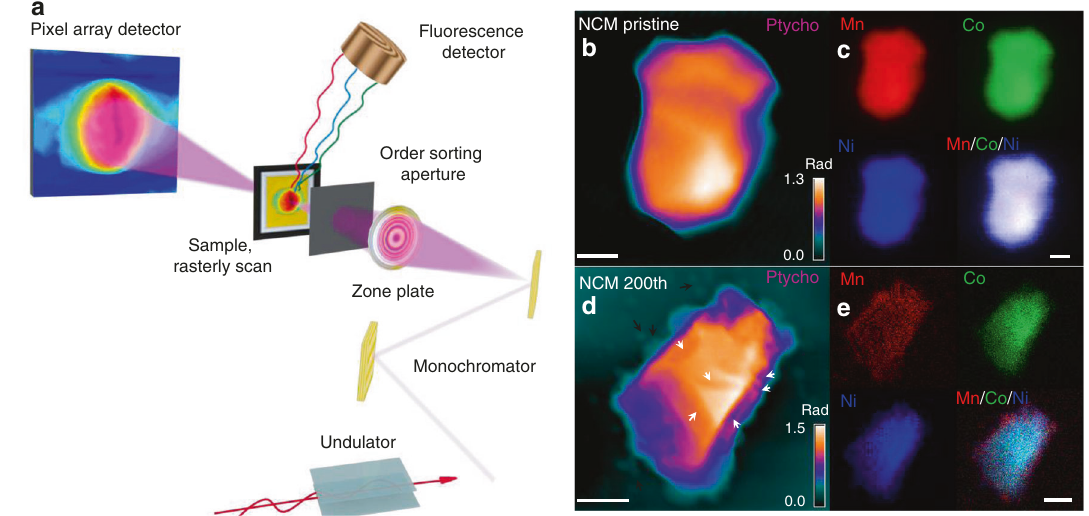
Fig. 5 Simultaneous X-ray fl uorescence and ptychography. a Experimental schematics. b – e X-ray fl uorescence and ptychographic images of pristine and 200th cycled NCM particles to show element distribution and morphology. Scale bars: b 2 μ m, c 1 μ m, d 2 μ m, e 1 μ